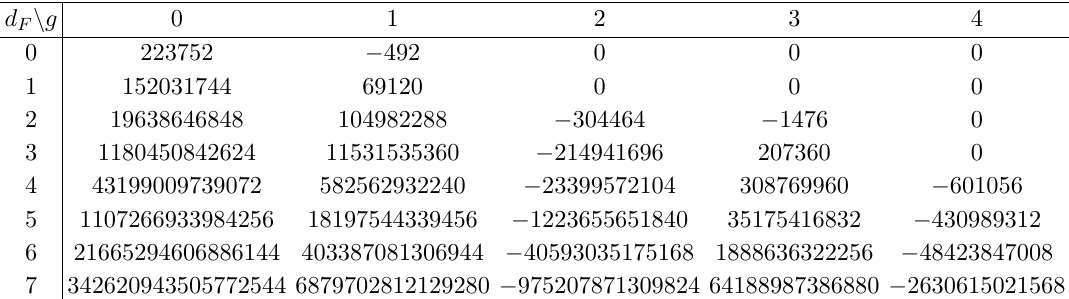
Table 6 . Gopakumar-Vafa invariants for ( F 4 ! P 2 )[ Z 2 ] (cid:0) 252